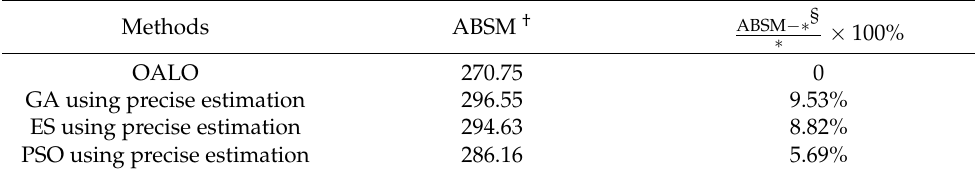
Table 4. Comparison of four approaches over 30 simulation trials.